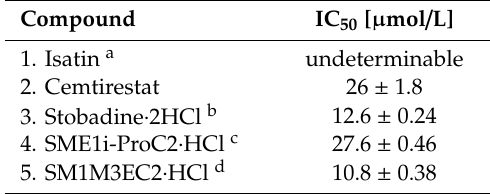
Table 2. Values of IC 50 determined by ABTS assay.